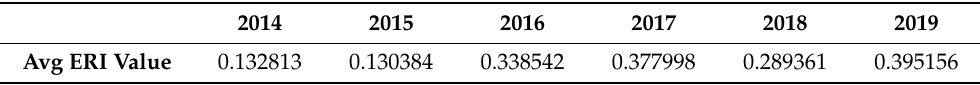
Figure 3. Overview of ERI CO values in the regions of the Slovak Republic during 2019. Own processing. Table 2. Average ERI CO values in the Slovak Republic in the period